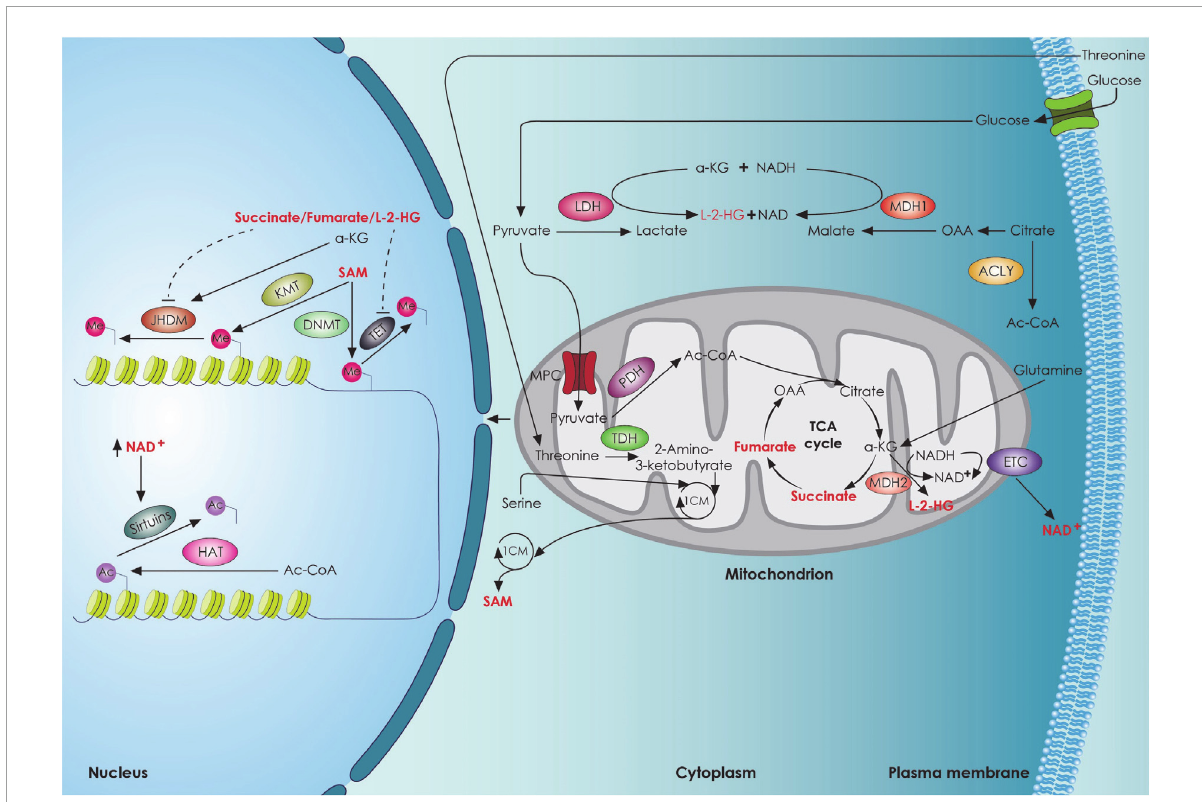
FIGURE3 TCA cycle metabolites and stem cell fate. The interplay between the metabolic mitochondrial and epigenetic factors regulating neural stem cell fate decisions. 1CM, 1-carbon cycle; Ac, acetyl group; Ac-CoA, Acetyl-CoA; a-KG, Alpha-ketoglutarate; ACLY, ATP citrate lyase; DNMT, DNA methyl transferase; ETC, electron transport chain; HAT, histone acetyl transferase; JHDM, JmjC domain-containing histone demethylation protein; KMT, histone lysine N-methyltransferase; L-2-HG, L-2-hydroxyglutarate; LDH, lactate dehydrogenase; MDH1, malate dehydrogenase 1; MDH2, malate dehydrogenase 2; Me, Methyl group; MPC, mitochondrial pyruvate carrier; NAD, Nicotinamide adenine dinucleotide; OAA, oxaloacetate; PDH, pyruvate dehydrogenase; SAM, S-Adenosyl methionine; TDH, threonine dehydrogenase; TET, Ten Eleven Translocation